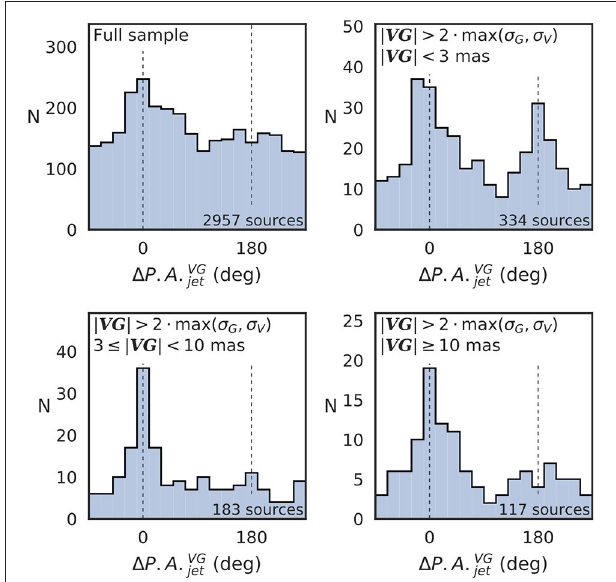
FIGURE 4 | Histograms of differences in position angle ( 1 P . A .) between the direction of the radio jet ( jet ) and the direction of the offset ( VG ) from radio to optical position of the source. All but the top-left panel plot only objects with the size of the offset VG being at least two times larger than the errors of their VLBI ( σ V ) and Gaia ( σ G ) positions. Vertical dashed lines indicate aligned and counter-aligned jets. From Kovalev et al. (2017), with